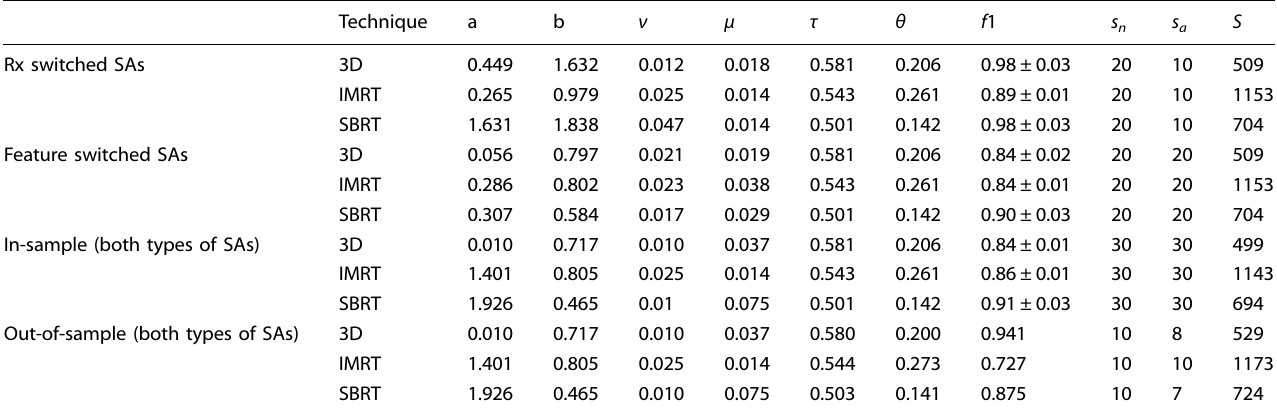
Table 1. Parameters and model performance scores.